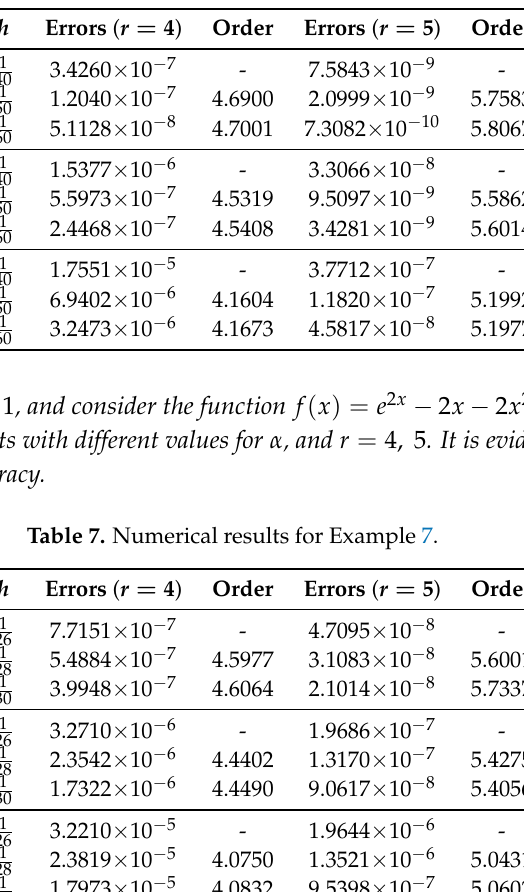
Table 6. Numerical results for Example 6.